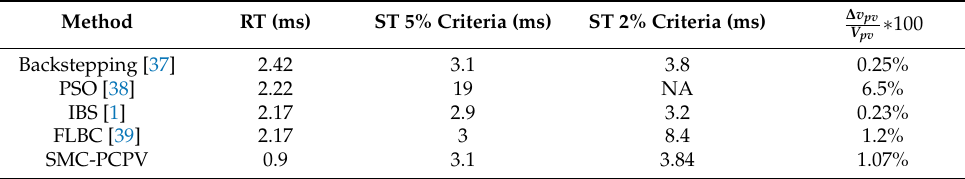
Table 5. Comparison of the dynamic